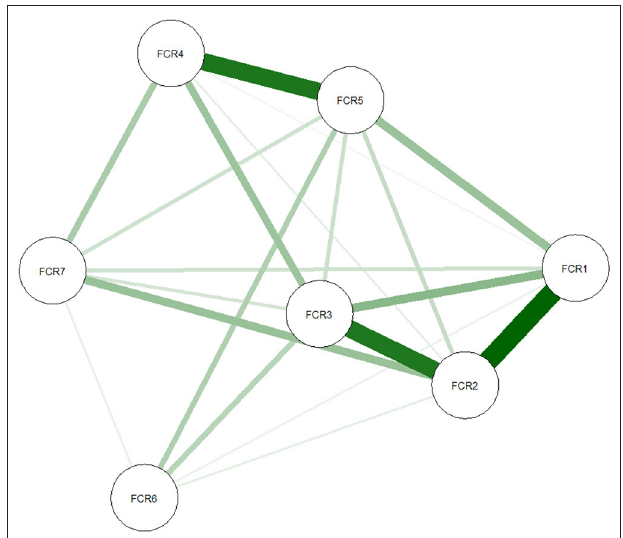
FIGURE 1 | Network of FCR symptoms. In this diagram, nodes with stronger correlations are closer to each other. The thickness of an edge indicates the strength of the correlation. Green lines indicate positive associations. FCR, Fear of Cancer